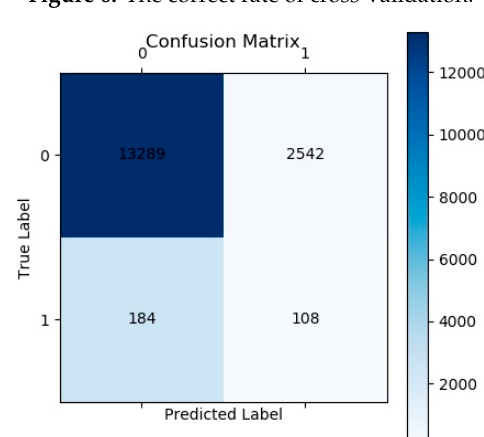
Figure 6. The correct rate of cross-validation.